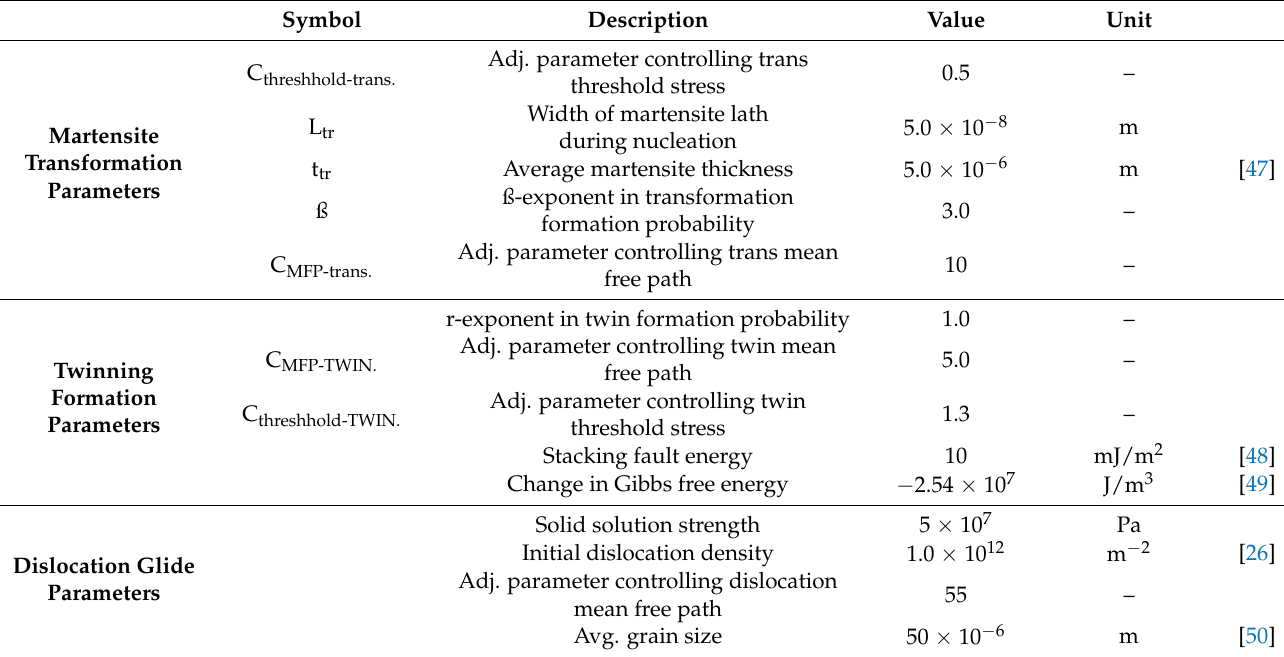
Table 1. Optimized constitutive model parameters for X8CrMnNi16-6-6 TRIP steel. The table has been adapted from a previous publication [28] and is being reprinted with the permission of MDPI.